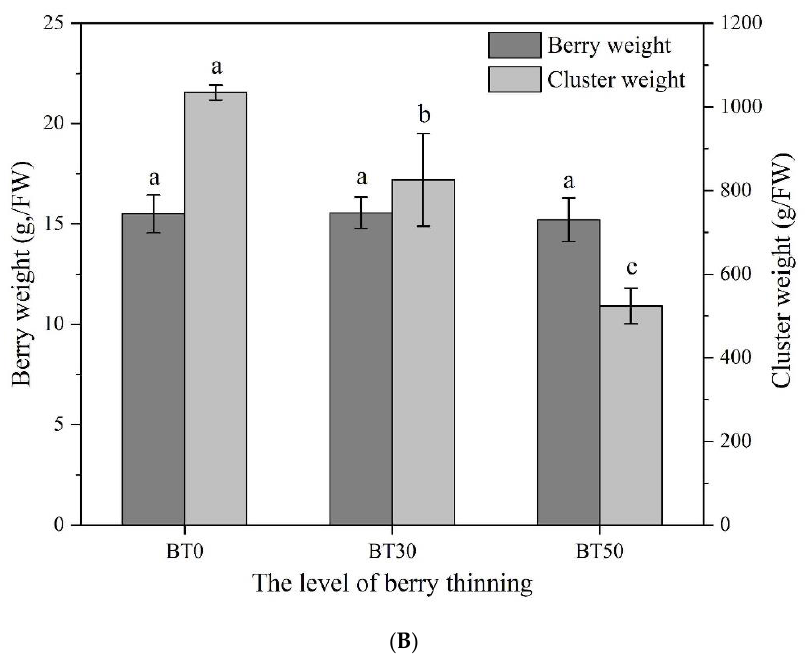
Figure 3. Effects of berry thinning on ( A ) the berry horizontal and vertical diameters and ( B ) berry and cluster weights of fresh Shine Muscat grapes: Different letters on the bars with the same color indicate statistically significant differences at p < 0.05.